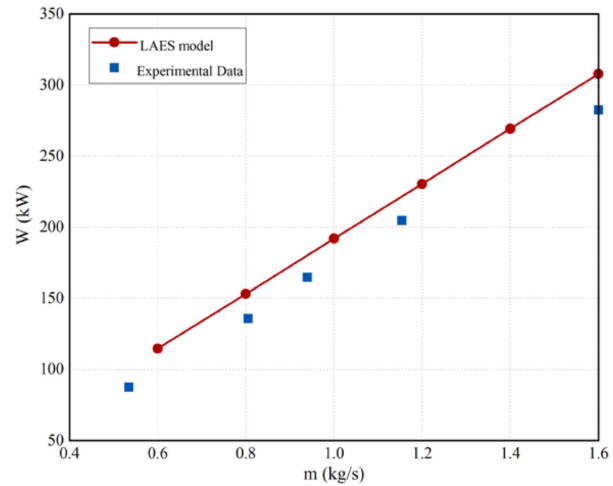
Figure 6. Model validation of the proposed LAES